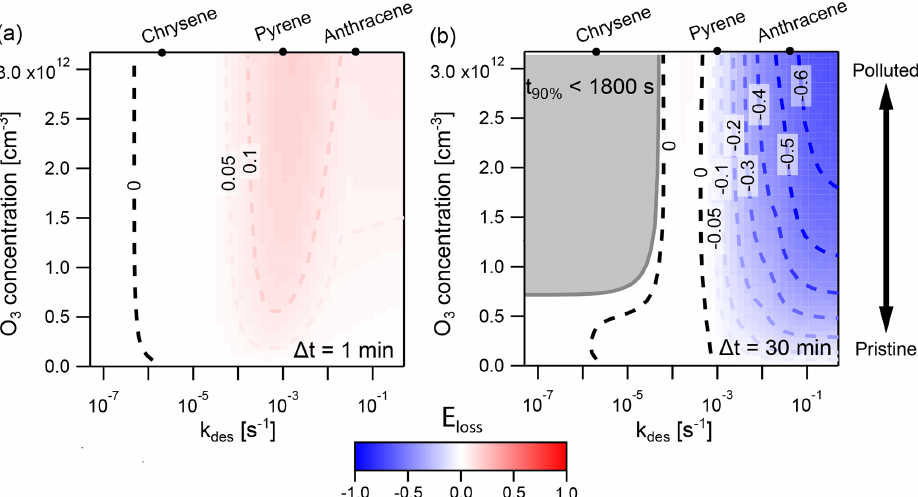
Figure 8. Discrepancy between the explicitly coupled (EC) solution and the operator-splitting (IE) solution for surface reaction of particle- phase PAHs with O 3 , determined with the error metric E loss . Regions where IE overestimates the loss of PAH are indicated in red (0 < E loss ≤ 1), and regions where it underestimates PAH loss in blue ( − 1 ≥ E loss < 0). The result is shown using two different operator-splitting time step lengths: (a) (cid:49)t = 1min and (b) (cid:49)t = 30min. The dark gray area indicates the conditions under which the time taken for total PAH to deplete by 90% ( t 90% ) is less than a single operator-splitting time step. The desorption rates for the PAHs chrysene, pyrene, and anthracene at 280K are indicated on the top